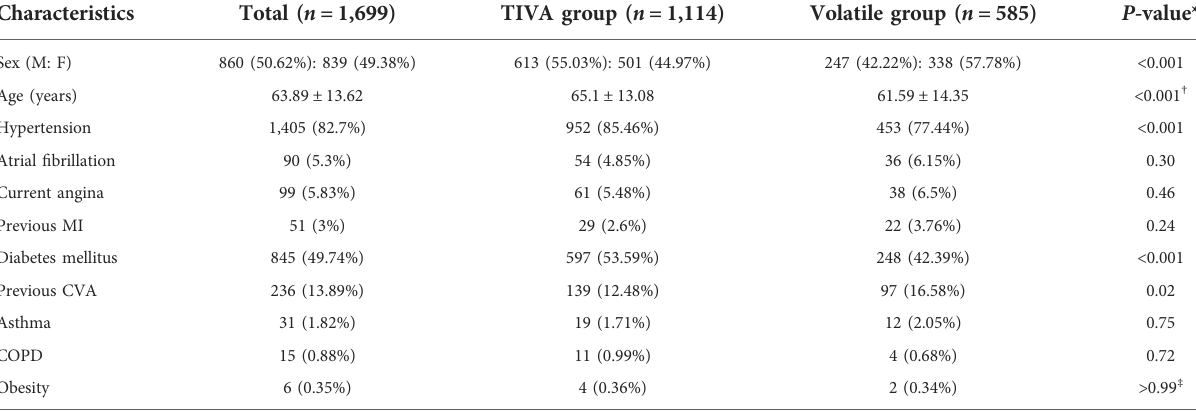
TABLE 1 Clinical patient